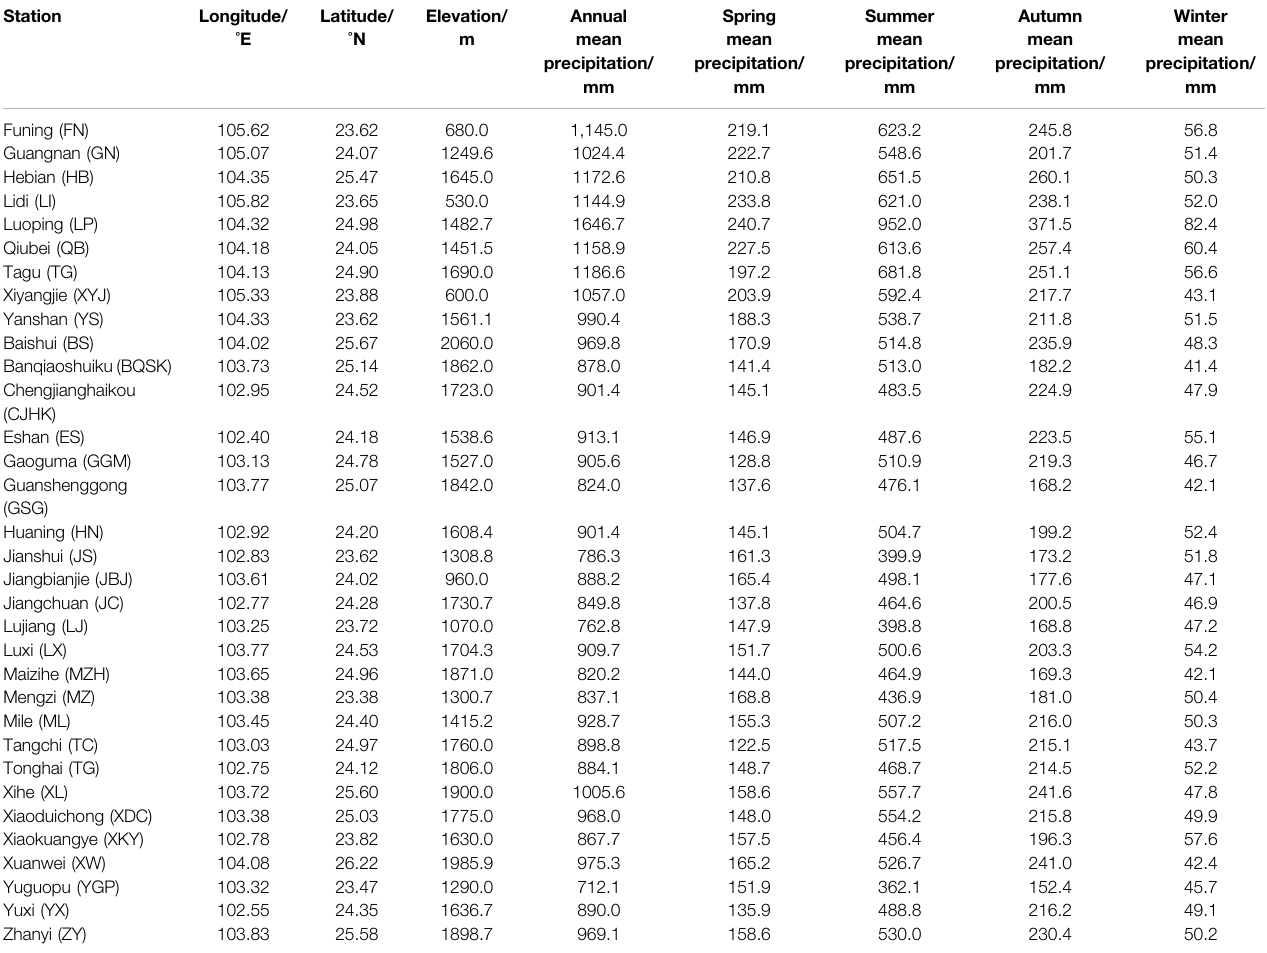
TABLE 1 | Geographic information and annual and seasonal precipitation at rainfall station of Nanpan River basin (1956-2016).